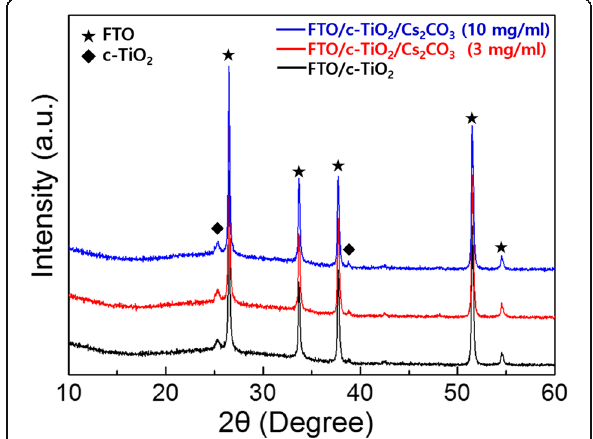
Fig. 4 XRD patterns of the c-TiO 2 on FTO glass substrates with and without Cs 2 CO 3